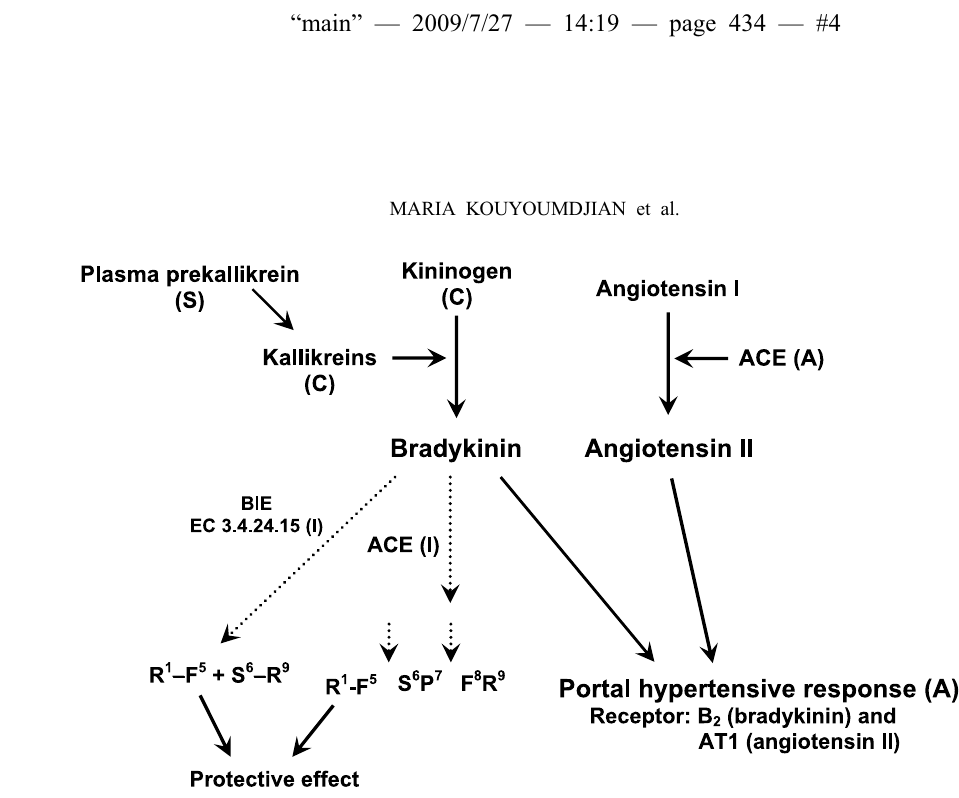
Fig. 1 – The liver and vasoactive peptides: bradykinin and angiotensin II. Legend: ACE: angiotensin converting enzyme; BIE: bradykinin inactivating enzyme; S: synthesis (Borges and Gordon 1976, Borges et al. 1981); C: clearance (Borges et al. 1985); I: inactivation (Kouyoumdjian et al. 1984, Molina et al. 2000); A: action (Borges et al. 1976, Loureiro-Silva et al. 2001, Carvalho et al. 2007).